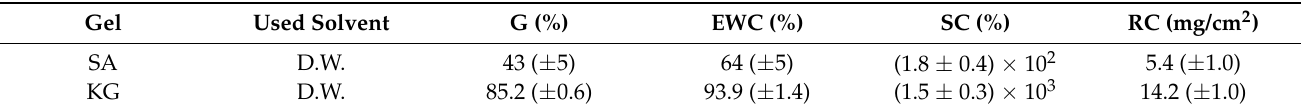
Table 1. Moisture properties of SA and KG gels used for the cleaning test, namely gel content (G), equilibrium moisture content (EWC), swelling capacity (SC), and retention capability (RC). The average values and the related standard deviations were determined by repeating the experiment five times. D.W. = distilled water.